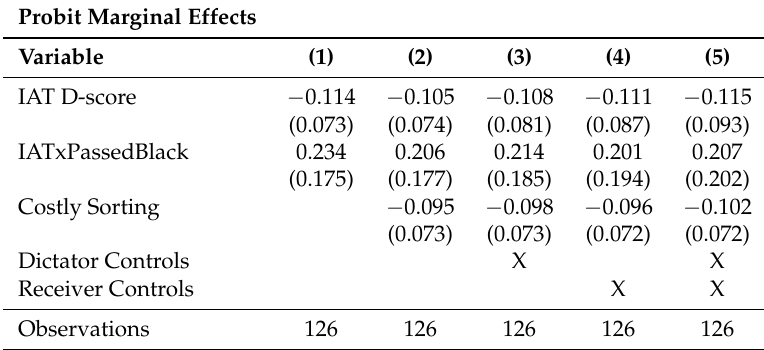
Table 10. The IAT’s effect on sorting.